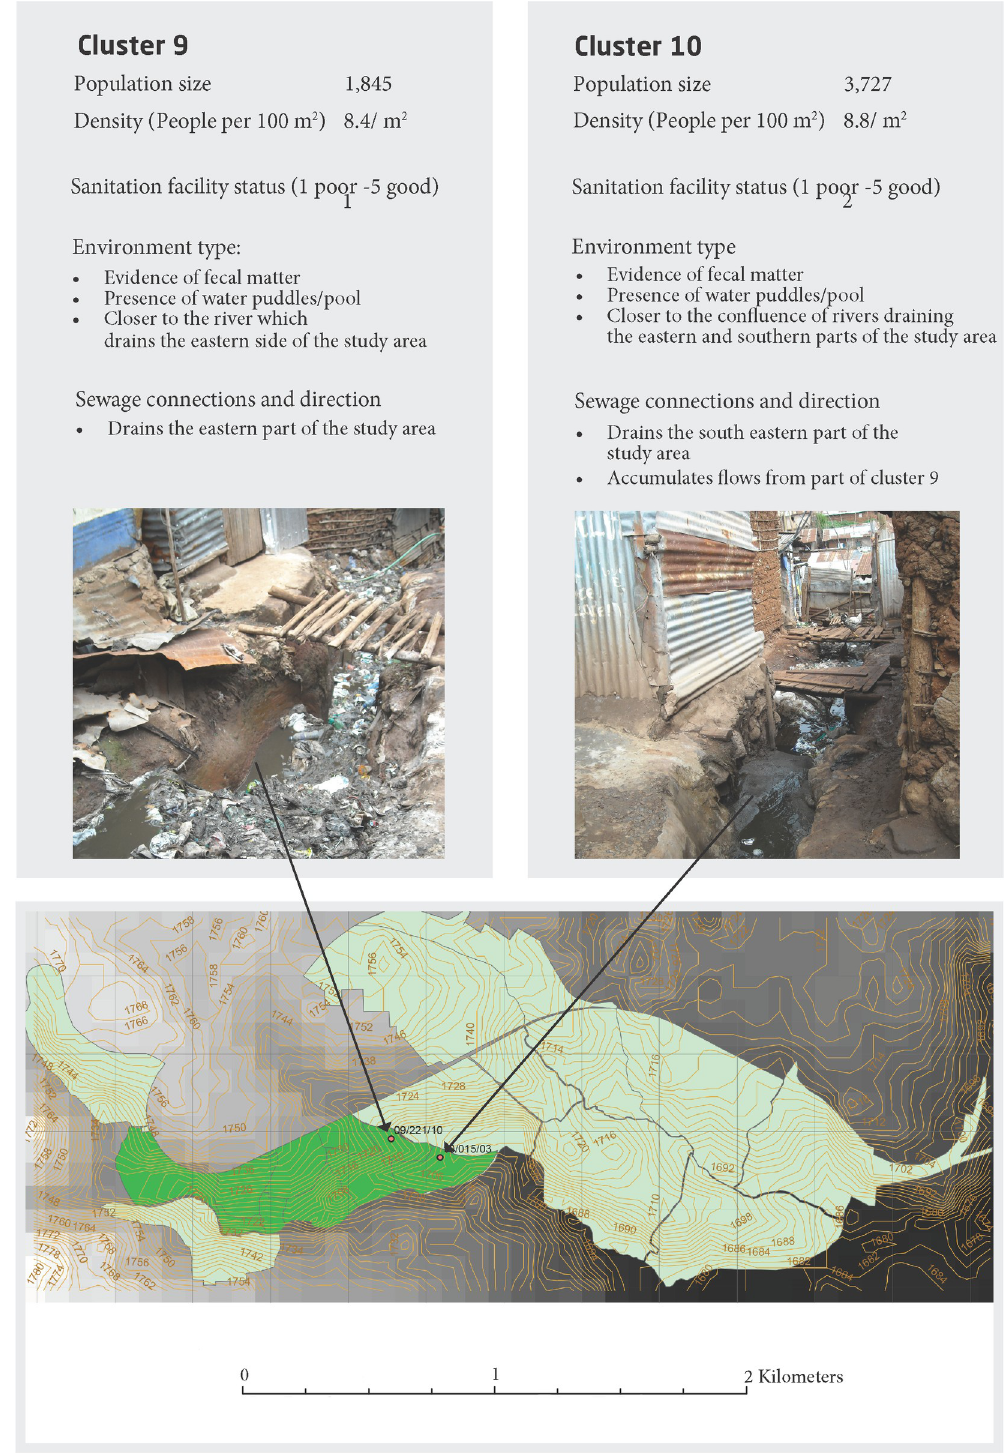
Fig 1. Geographical overview and location and description of the residence clusters 9 and 10 of the urban slum city of Kibera, Nairobi, Kenya. Sampling points marked with a red circle, brown lines indicate hill contours, dark green mark the PBIDS, black lines separate the residence clusters, light green mark the urban slum city. Photograph provided by the author Eric Ngeno.